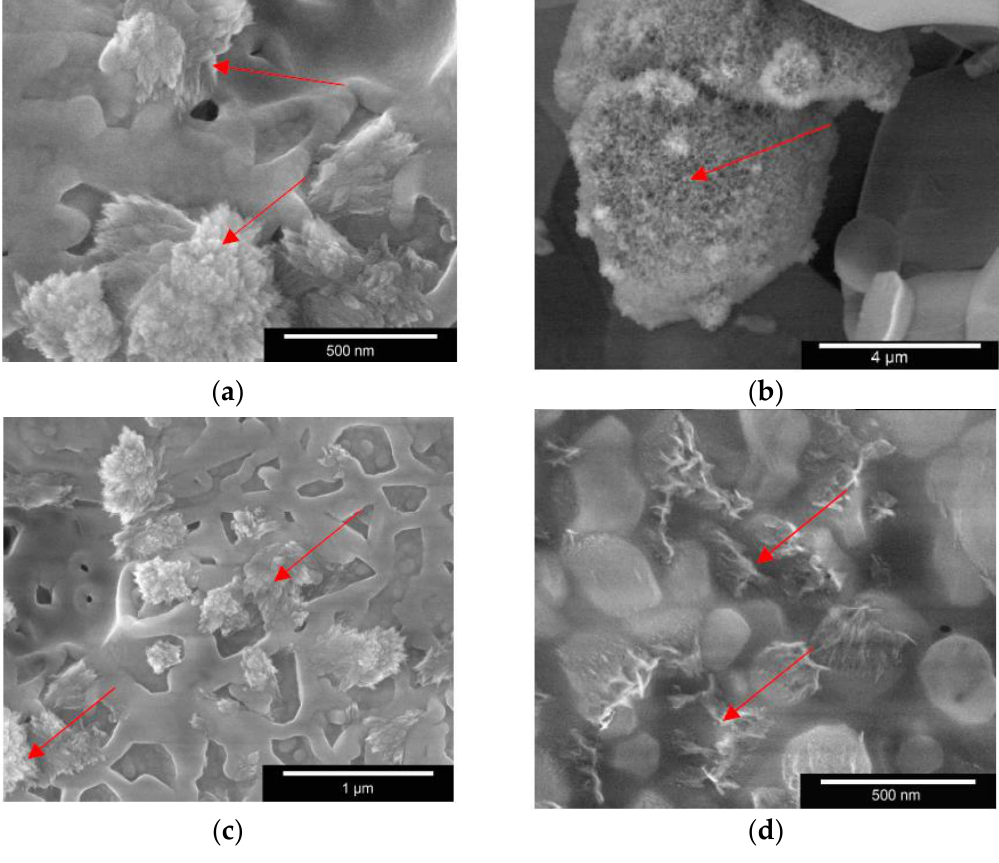
Figure 10. Low-vac SEM images showing crystal formation on scaffold surfaces: ( a ) BG; ( b ) β-TCP; ( c ) 50/50; and ( d ) 70/30. Red arrows indicate the HA crystals after immersion in SBF for 28 days. Images were taken with FEI Quanta 250 FEG, Large Field Detector, 5 kV, 100 Pa.